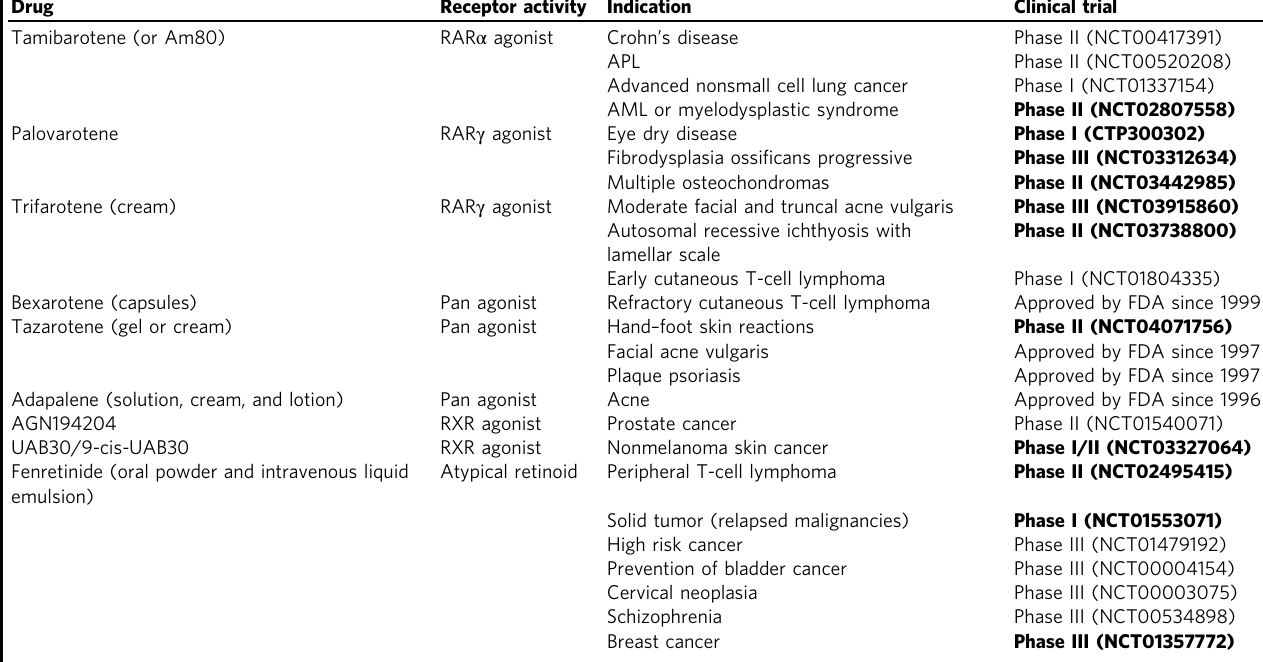
Table 2 Synthetic retinoids in terminated or active (in bold) clinical trials and approved for commercialization.